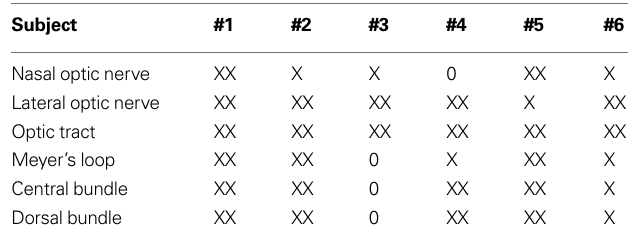
Table1 | Reconstructed fi ber bundles for individual